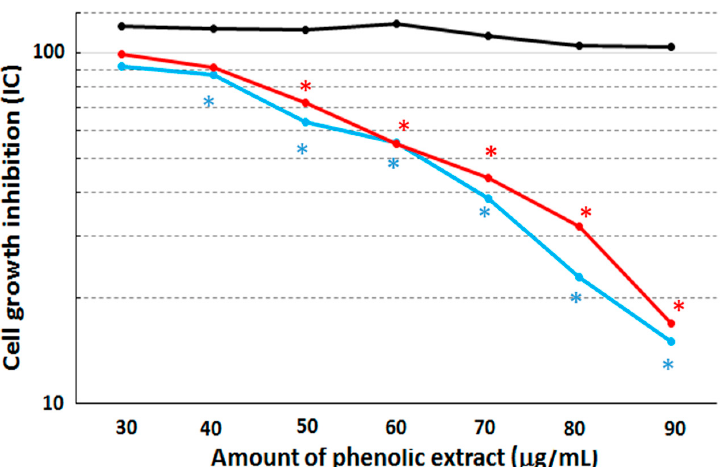
amount of phenolic extract from FS oil on normal human breast epithelial cells, MCF-10A (in black), and two human breast cancer cells, MCF7 (in cyan) and MDA-MB231 (in red). The statistically significant differences between treated and untreated samples are indicated by *.